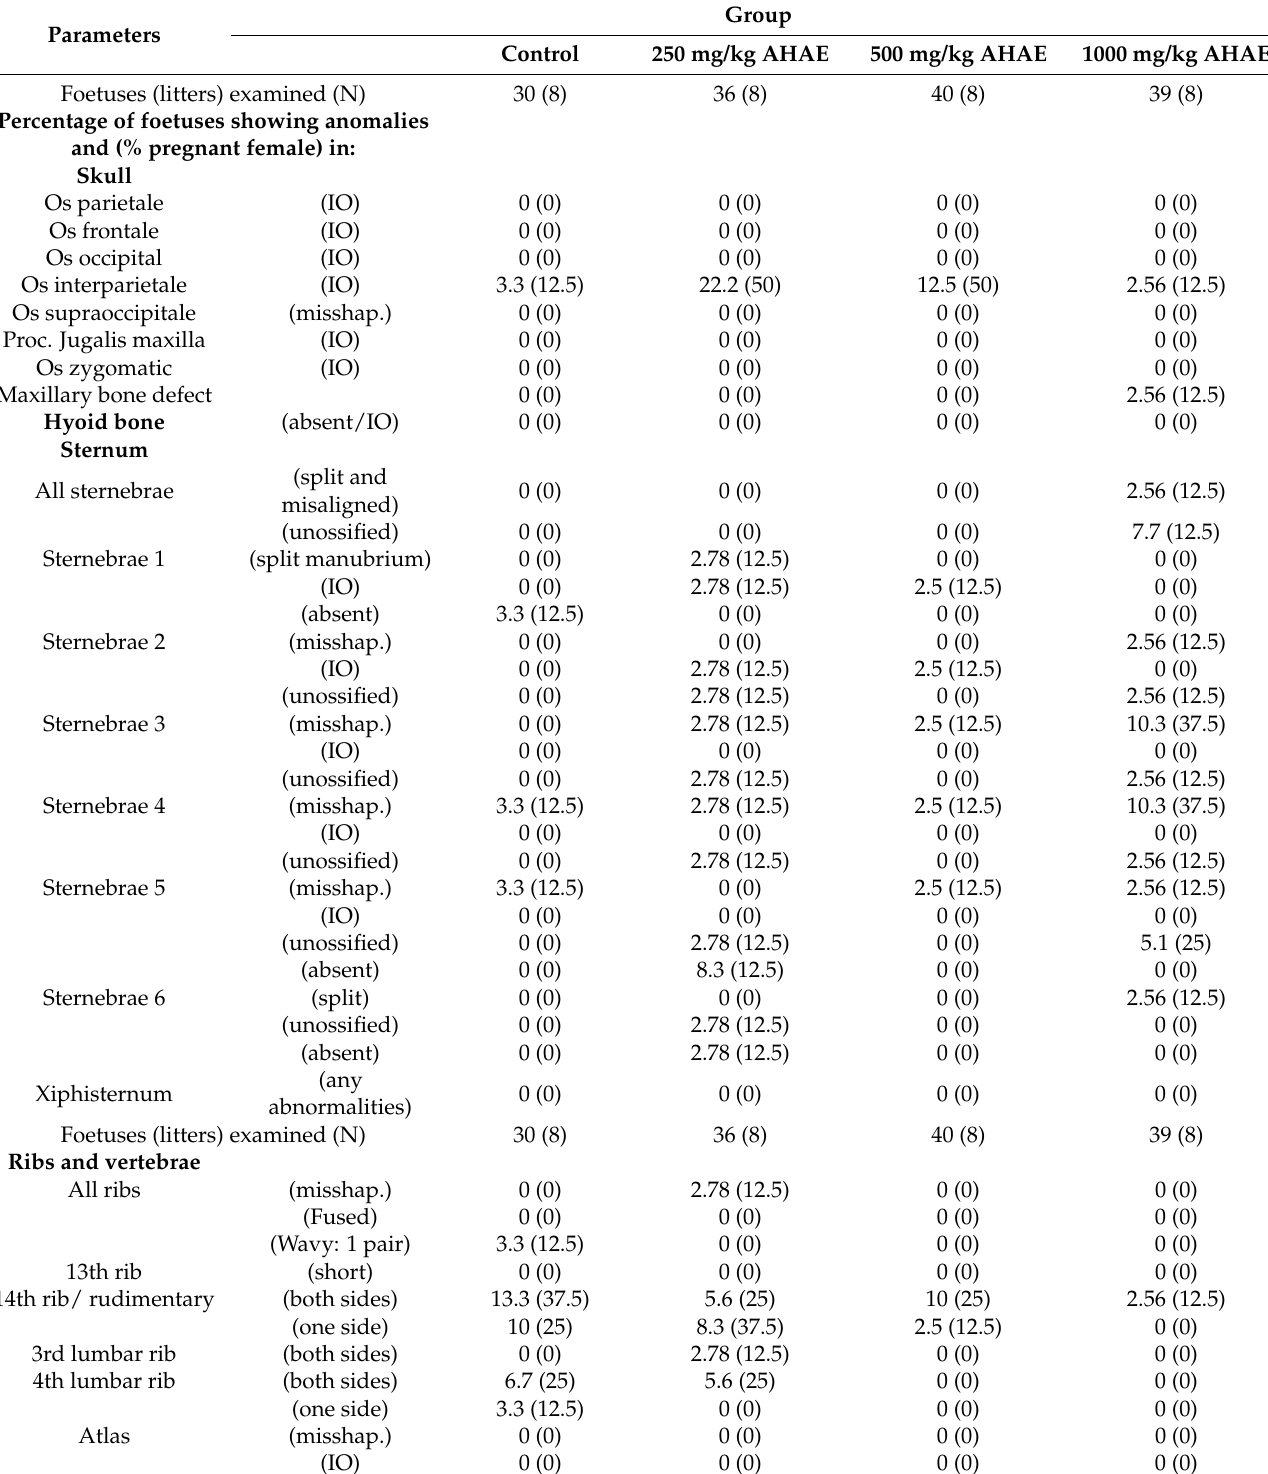
Table 2. Occurrence of skeletal abnormalities in the offspring of SD rats treated with different doses of